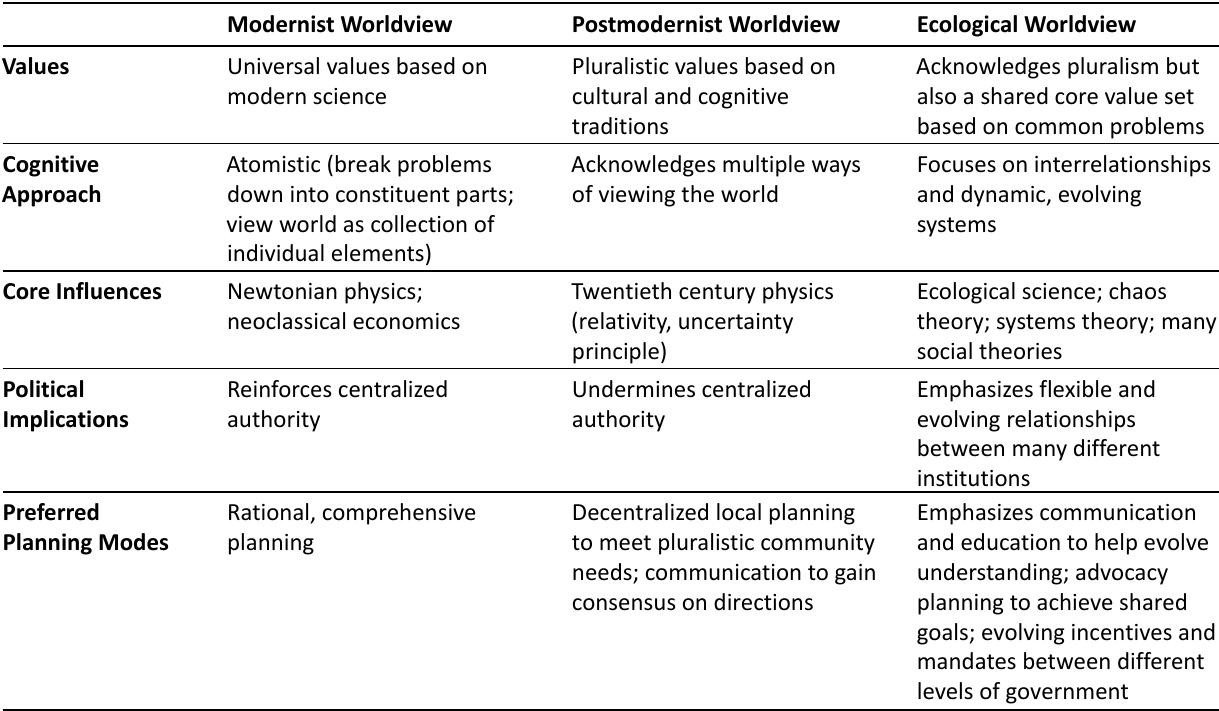
Table 1. Modernist, postmodernist, and ecological